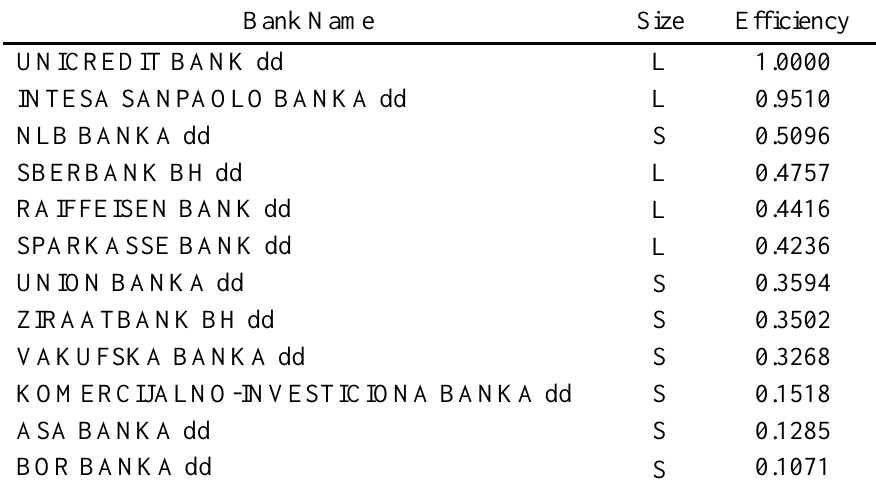
Table 2. Bank efficiency in 2016